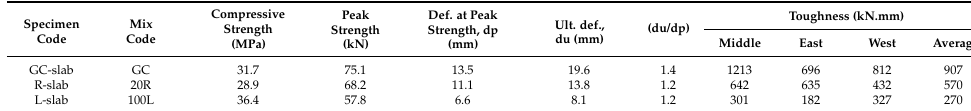
Table 4. Reinforced geopolymer concrete slabs test results.